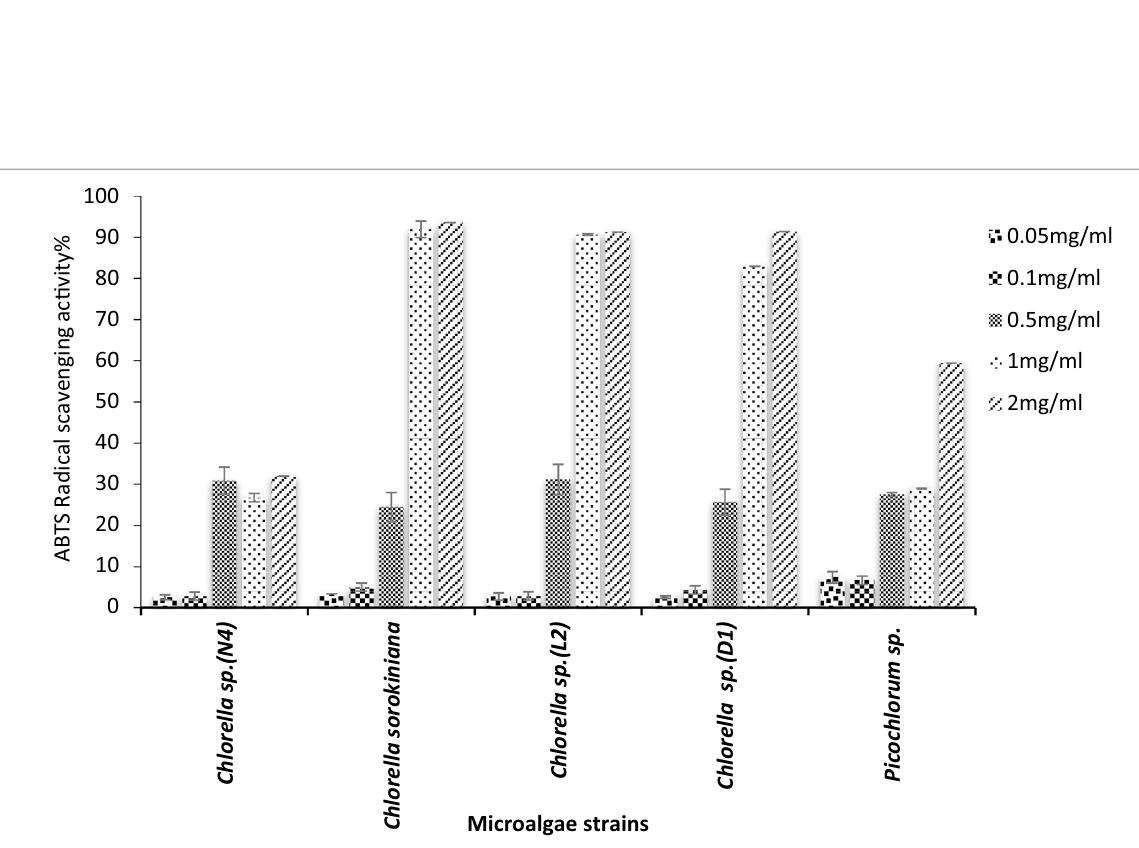
Fig. 7 Antioxidant activity, ABTS radicals scavenging activity by sPS extracted of various microalgae